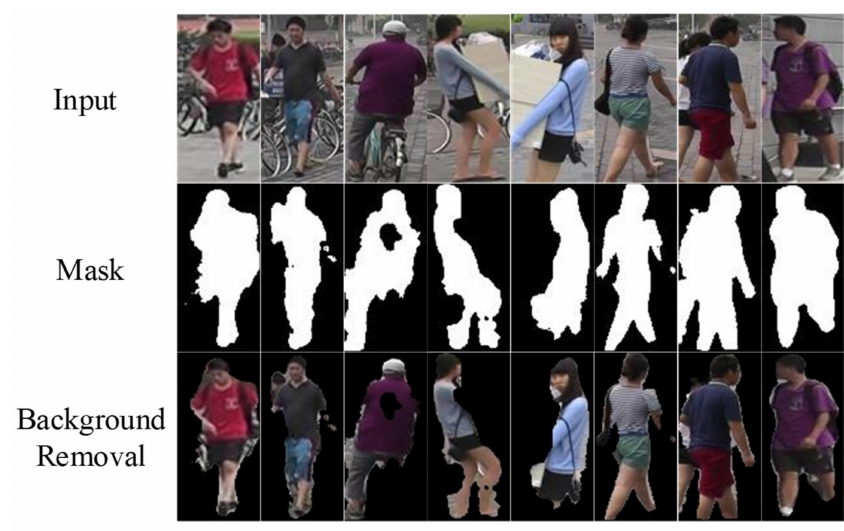
Figure 5. Some examples of the pedestrian background removal